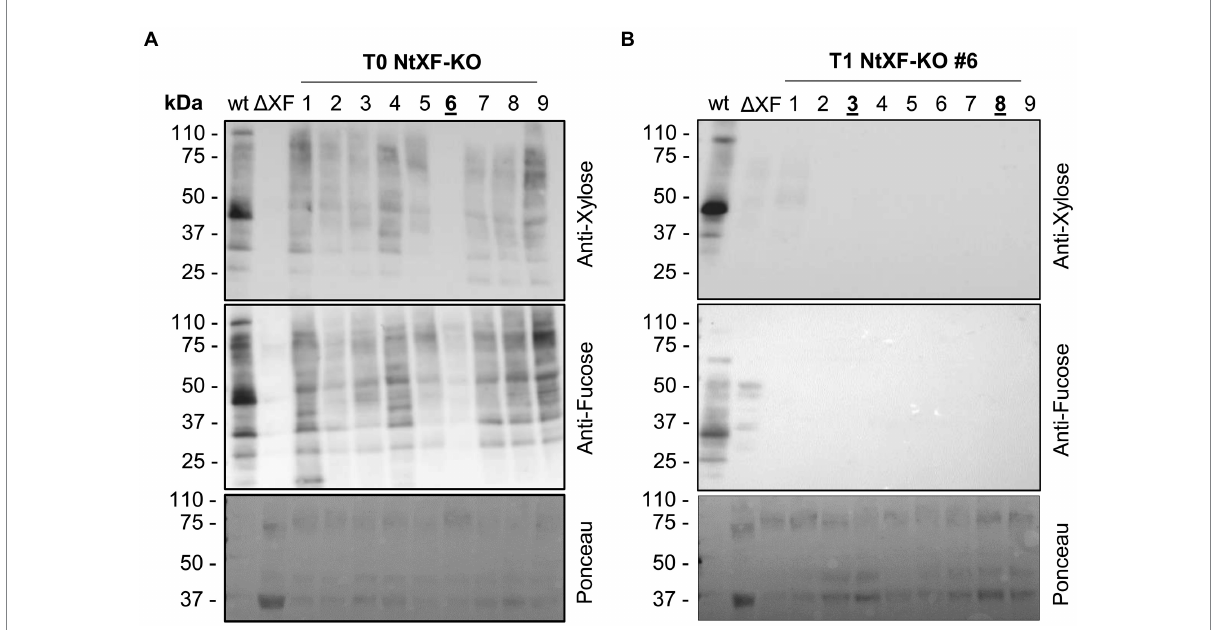
FIGURE 1 Western blot analysis of total soluble protein from the T 0 (A) and T 1 (B) generations of transgenic NtFX-KO lines. About 10 μ g of total soluble protein from wild-type Nicotiana tabacum cv. SR-1 (wt), putative NtFX-KO lines and N. benthamiana Δ XF/FT plants ( Δ XF; kindly provided by BOKU Vienna), were loaded and incubated with either rabbit anti- α (1,3)-fucose or anti- β (1,2)-xylose antisera, followed by HRP-labeled goat-anti-rabbit H + L antisera. Ponceau staining of probed nitrocellulose membranes was used as loading